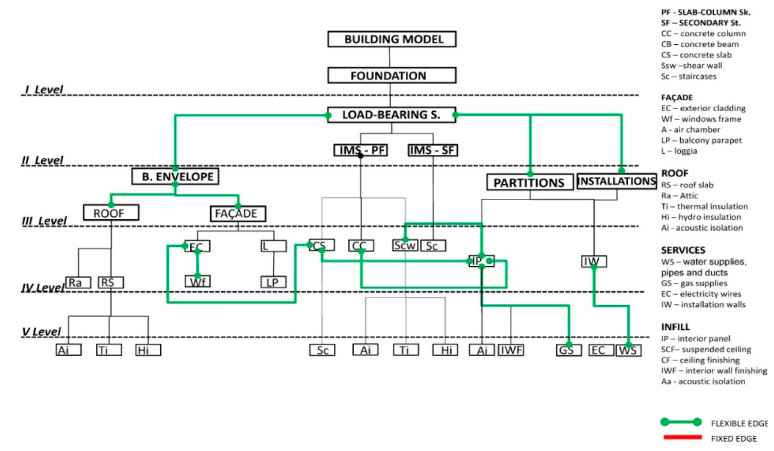
Figure 12. Graph Model for the building No. 06B2 in Block 63.